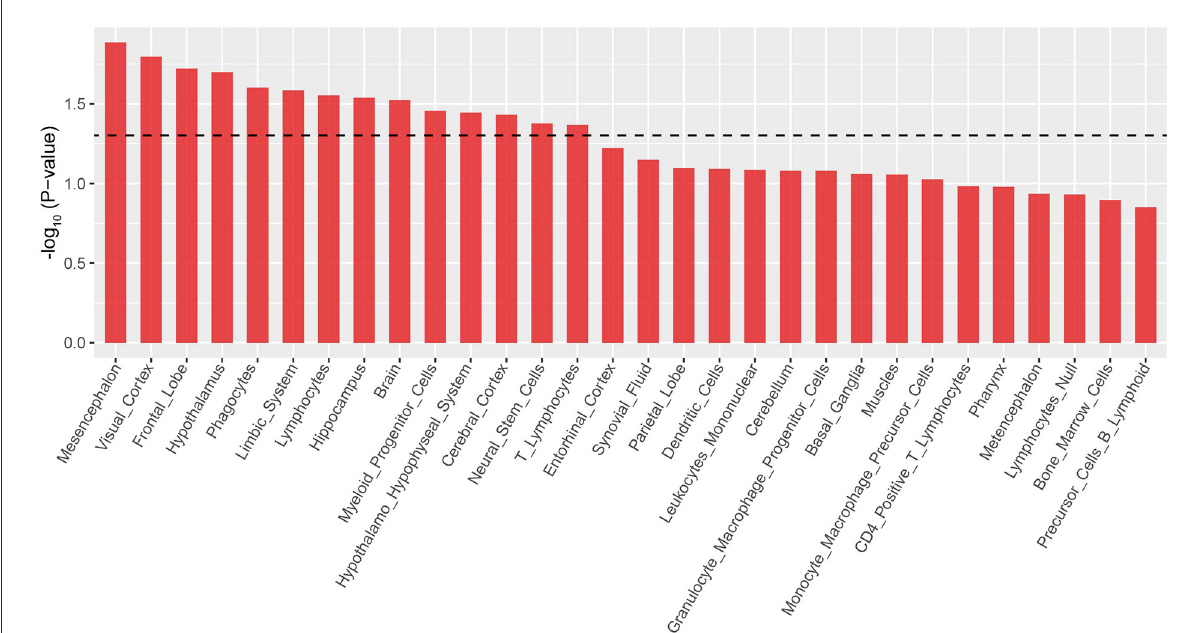
FIGURE3 LDSC-SEG analysis results of ADHD-relevant tissues. Only the top 30 tissues are shown according to the descending order of log 10 ( p